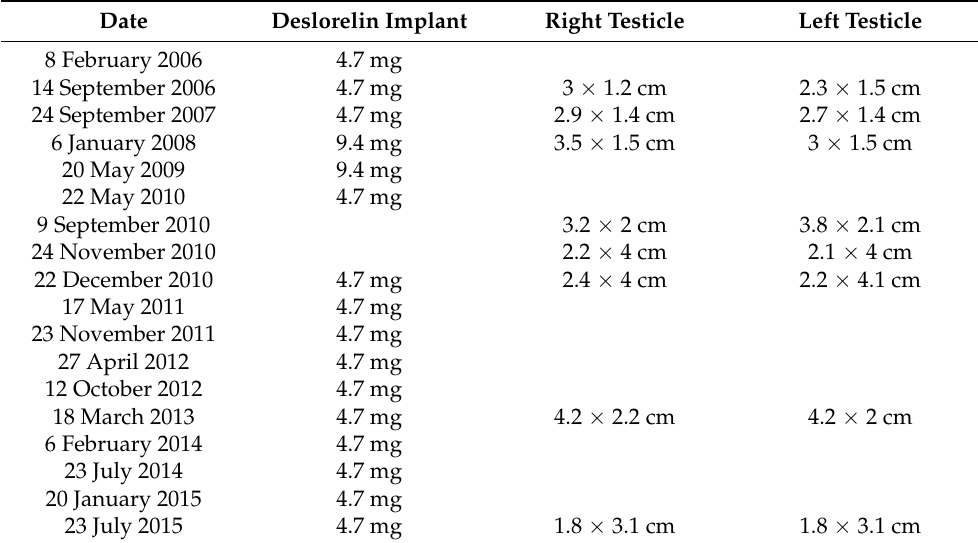
Table 1. Date of implantation and variations in testicular size of a Maremma shepherd dog treated continuously with deslorelin between 2006 and 2015. Measures were taken at most clinical checks prior to reimplantation and reflect size of the right and left testes as measured during clinical examination using a stainless-steel